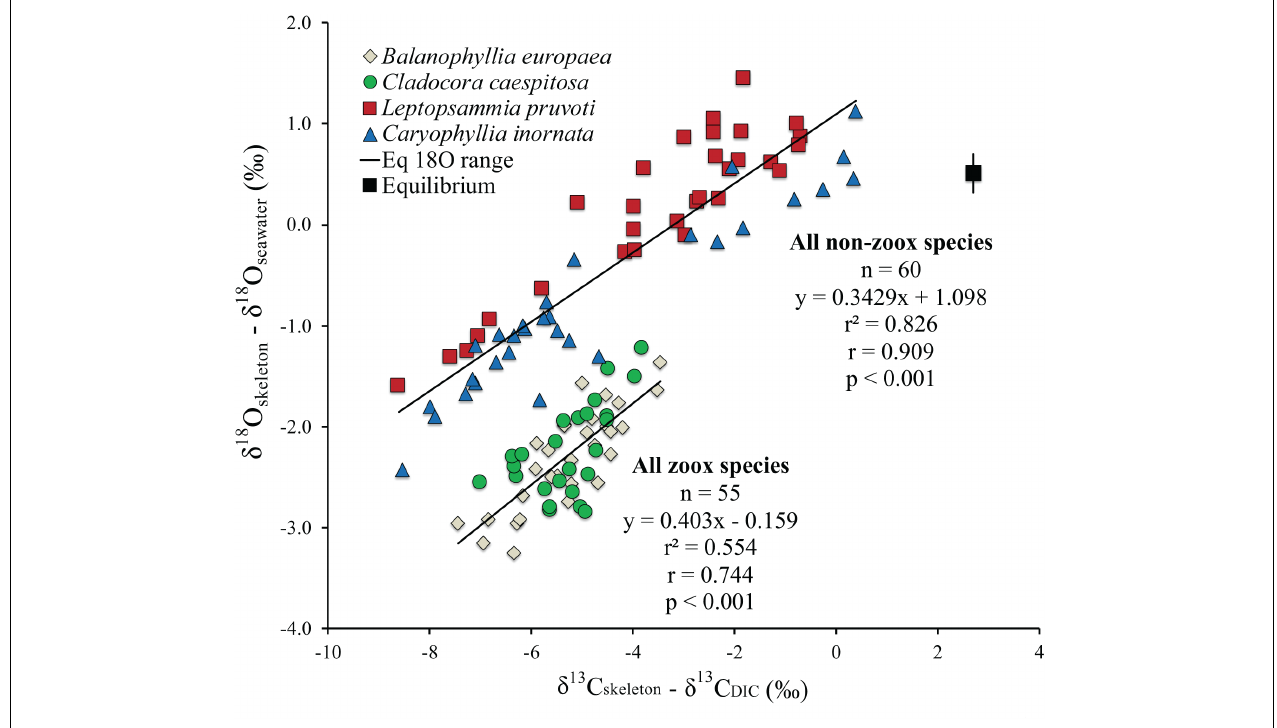
FIGURE 3 | Isotopic comparison between Balanophyllia europaea (zooxanthellate), Cladocora caespitosa ( zooxanthellate), Leptopsammia pruvoti (non-zooxanthellate), and Caryophyllia inornata (non-zooxanthellate) at 6 sites along the west coast of Italy ( ∼ 850 km transect). Regression lines are the best fit to the zooxanthellate and non-zooxanthellate data sets. The black square indicates the estimated aragonite equilibrium value for average annual temperature for the 6 sites along the gradient using Grossman and Ku (1986) for oxygen and Romanek et al. (1992) for carbon. Vertical bar indicates equilibrium values corresponding to maximum and minimum average temperature. r 2 , Pearson’s coefficient of determination; r , Pearson’s correlation coefficient; n , number of